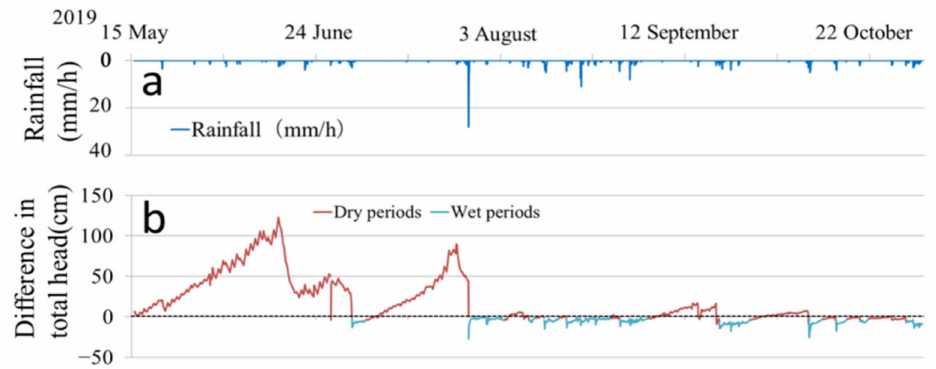
Figure 9. ( a ) Rainfall and ( b ) the difference in total head between the depths of 30 and 50 cm at Point